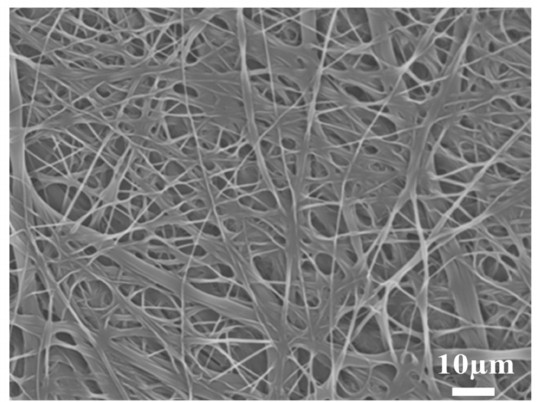
Figure 3. SEM micrograph of the PBT–EVOH polymer composite film, prepared with the triallylamine crosslinking agent ratio of 1.5%.